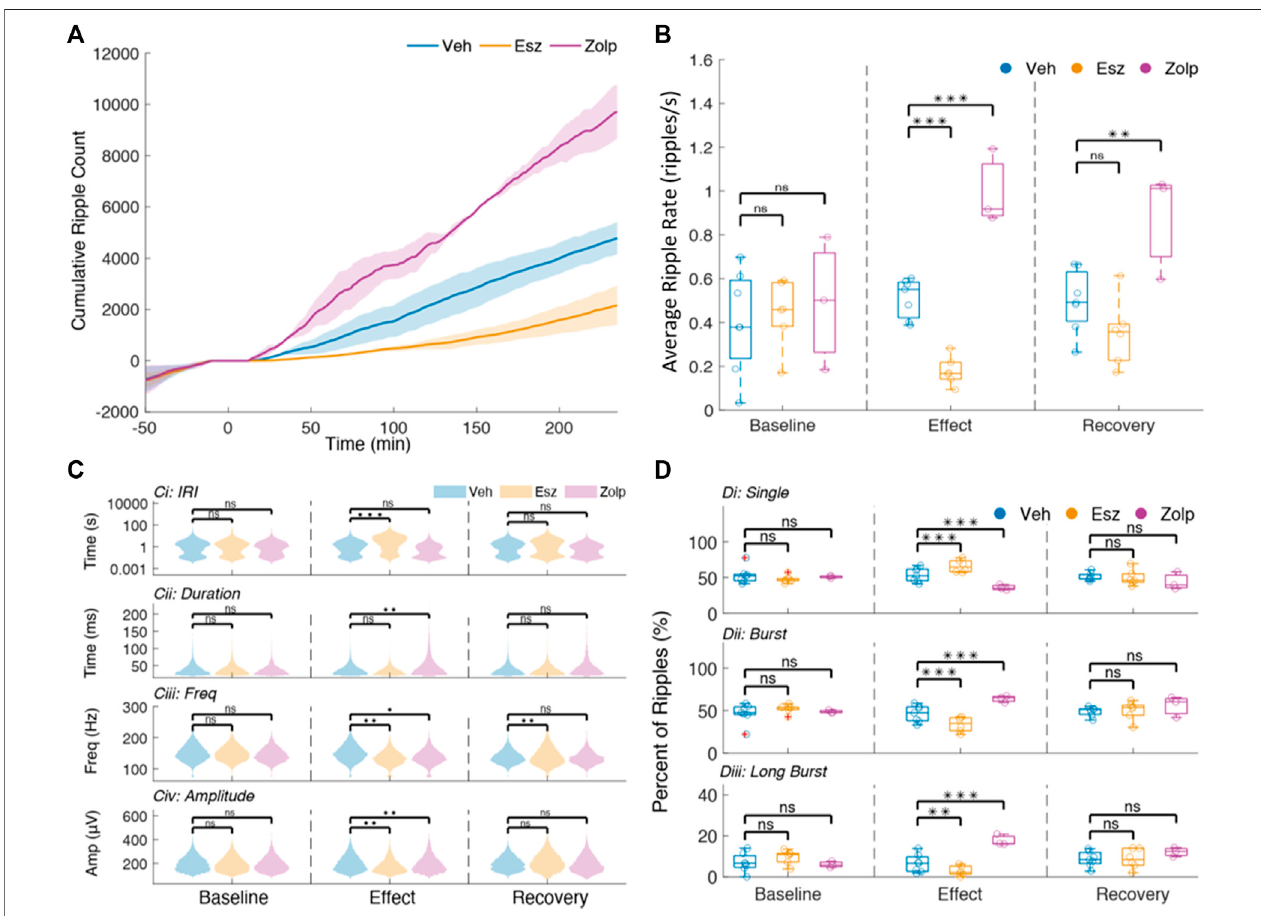
FIGURE 2 | Ripple sparsity increases after eszopiclone and decreases with zolpidem. (A) Mean cumulative ripple counts across sessions with shaded standard deviations for vehicle, Eszopiclone and Zolpidem ( n (cid:1) 4 rats; see Supplementary Table S2 for details). Time 0 indicates injection. (B) Mean ripple rate (per second) withineach time window ofinterest inall sessions (eachcircleonesession).Signi fi cancewasdeterminedusing anF-test on a fi tted mixedlinear model. (C) Violin plotsof Inter-Ripple-Intervals (top row, y -axis log scaled ) , Ripple duration (second row), Intra-ripple frequency (third row) and normalized ripple amplitude (bottom row) , comparing Vehicle (blue), Esz (red) and Zolp (purple) across time windows: Baseline (left) , Effect (middle), and Recovery (right) . (D) Distribution of the proportion of “ single ” ripples (Di), ripple bursts (Dii) and “ long ” ripple bursts (bursts with four ripples or more; Diii) for all sessions during Baseline, Effect and Recovery.